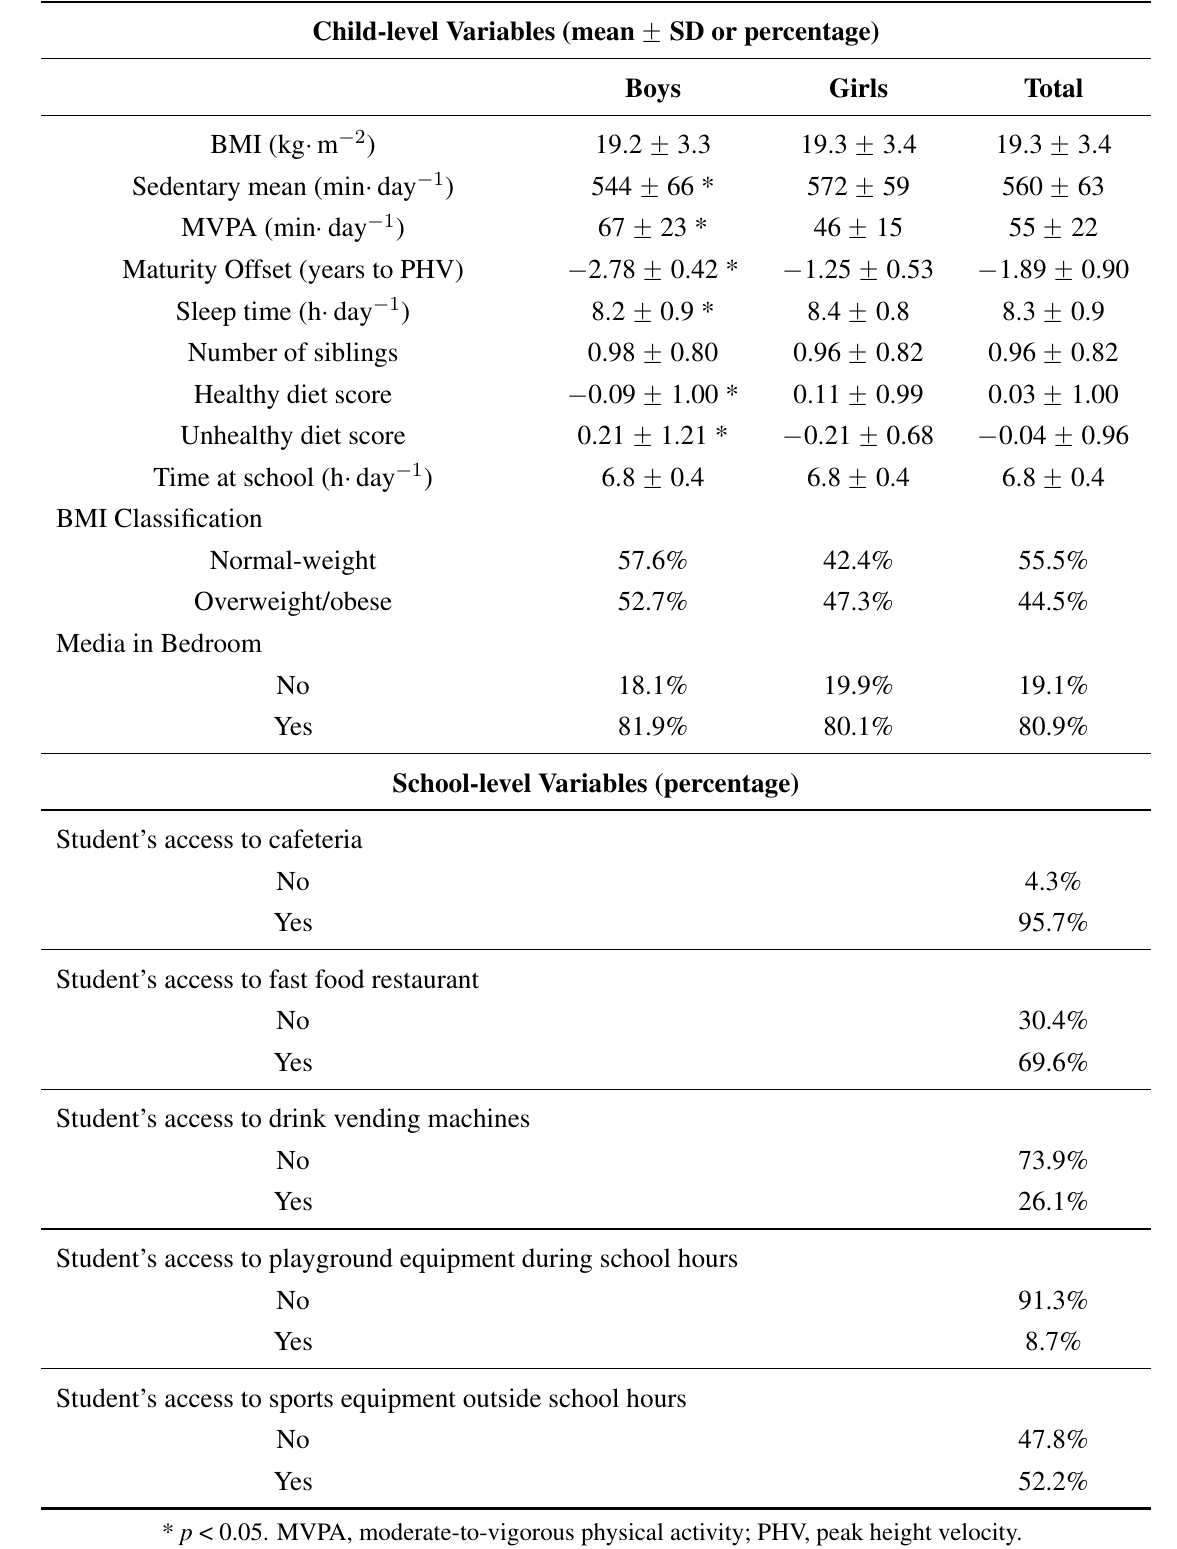
Table 1. Descriptive statistics for variables at the child (level 1) and school level (level